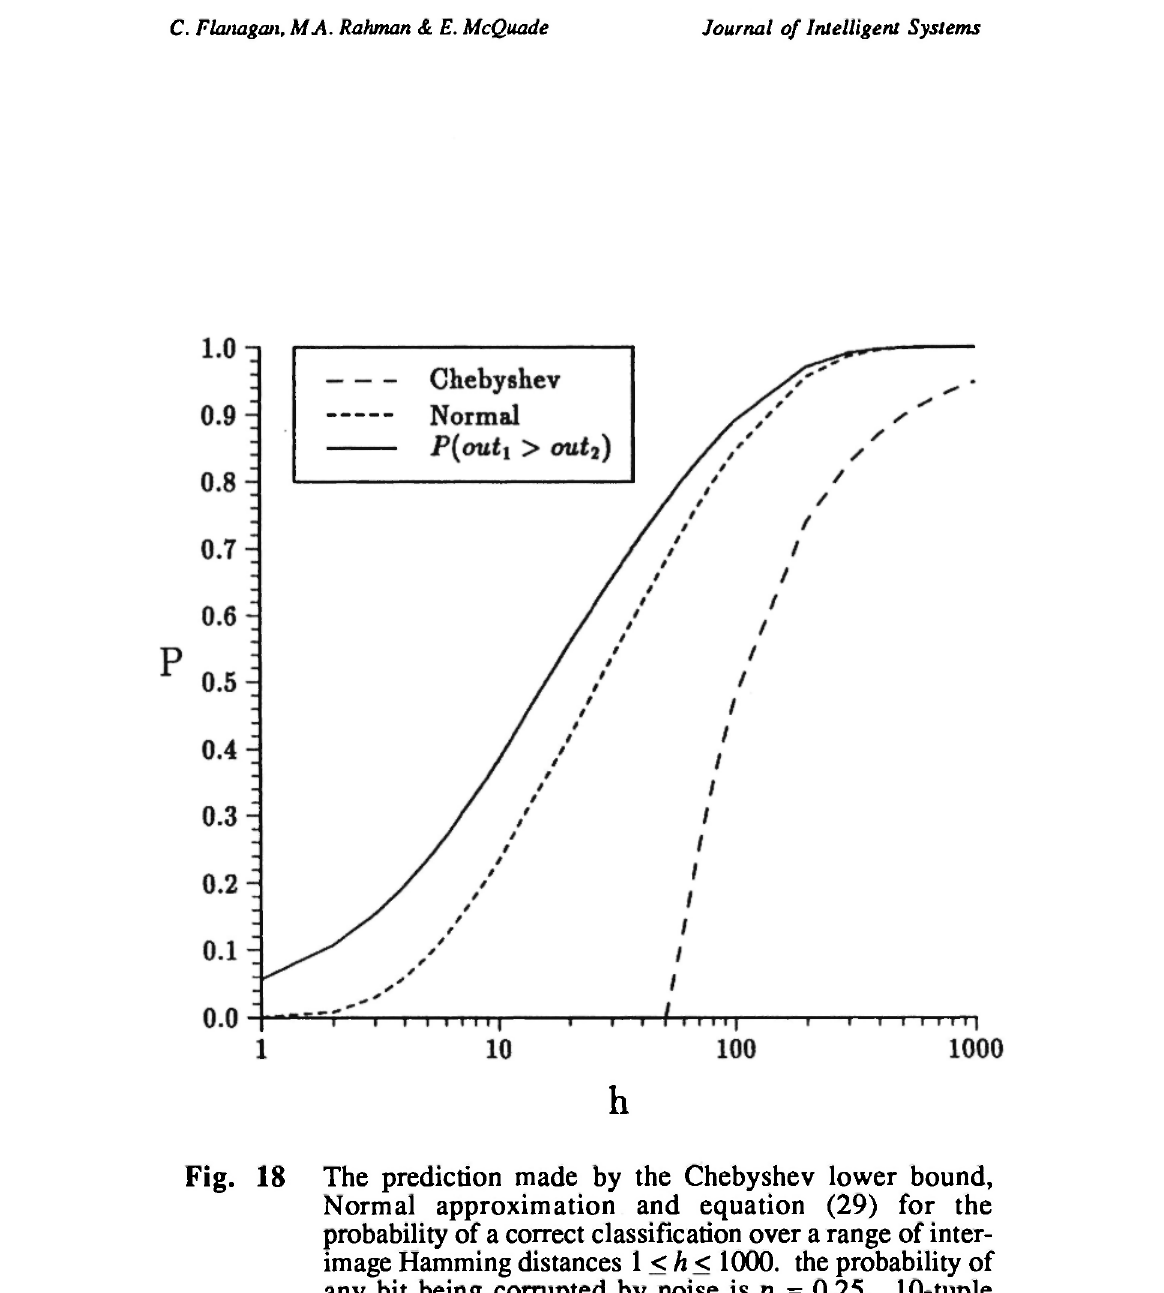
h Fig. 18 The prediction made by the Chebyshev lower bound, Normal approximation and equation (29) for the probability of a correct classification over a range of inter- image Hamming distances 1 <h< 1000. the probability of any bit being corrupted by noise is ρ = 0.25. 10-tuple sampling